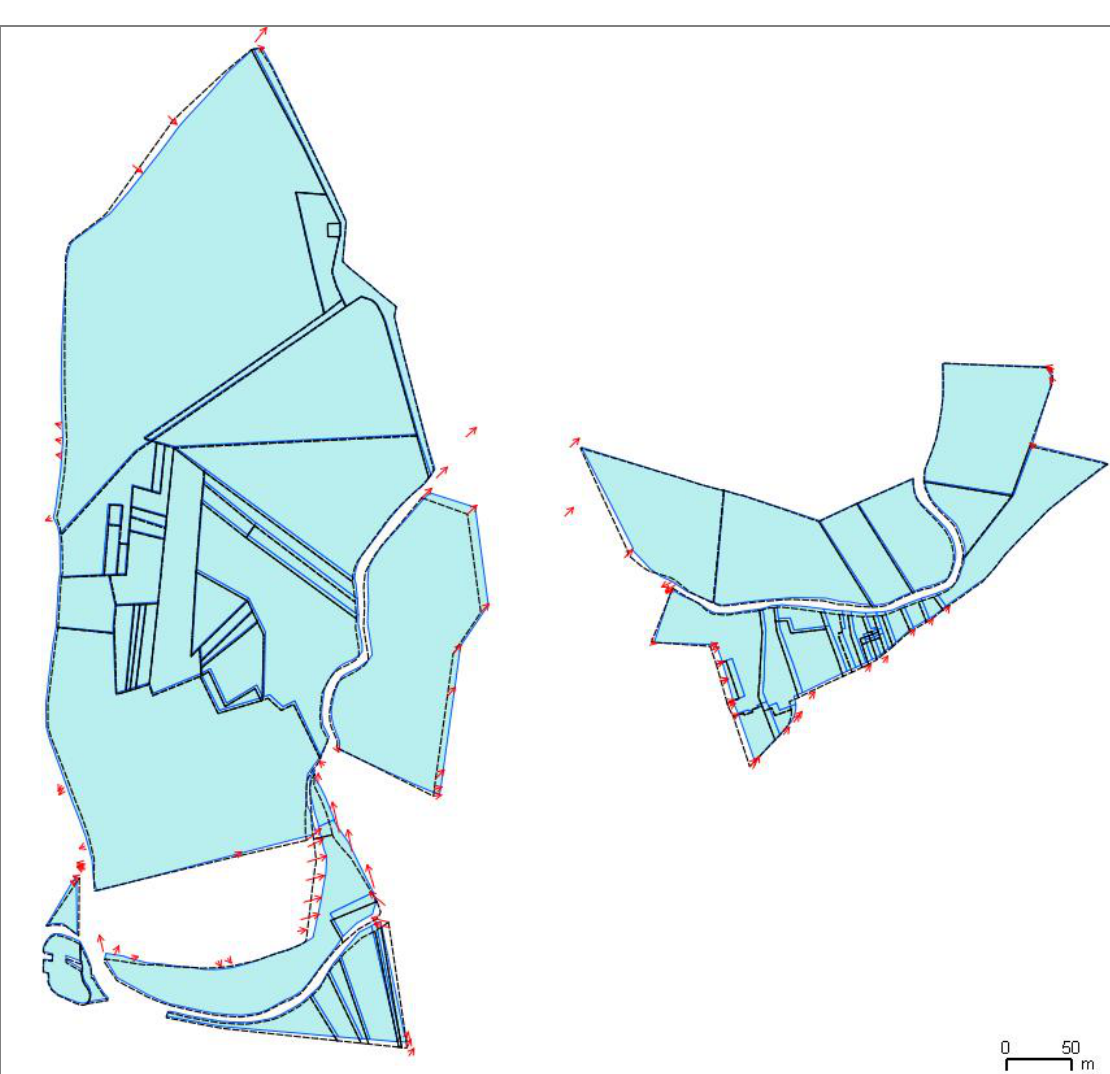
Figure 18. Conflation results with data that require large distortions (conflated parcels are in plain blue, initial outlines are dashed and arrows show matching vectors).